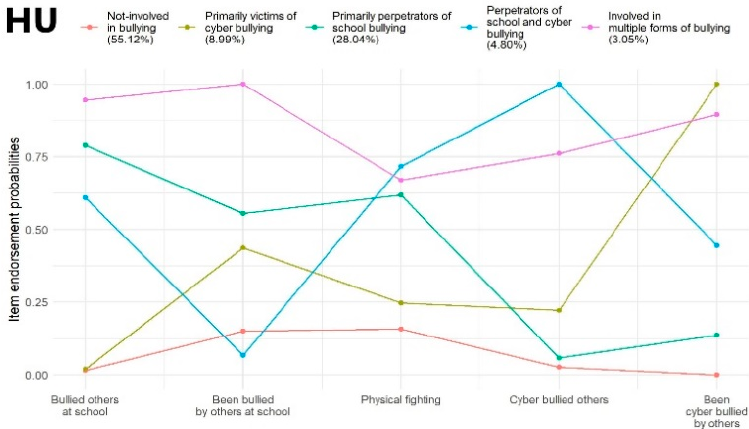
Figure 2. Latent class profile of Hungary.